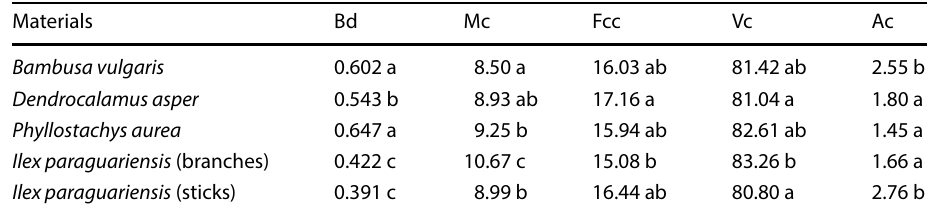
Table 2 Average values of basic density, moisture content and proximate